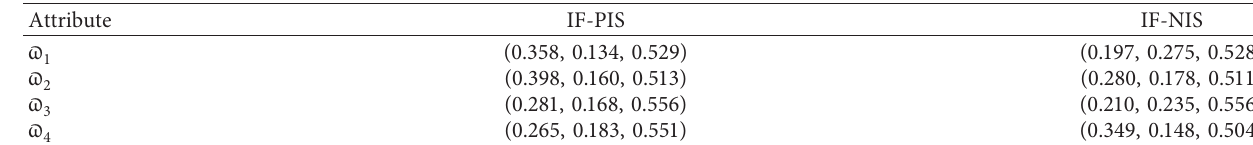
Table 28: IF-PIS and IF-NIS values.